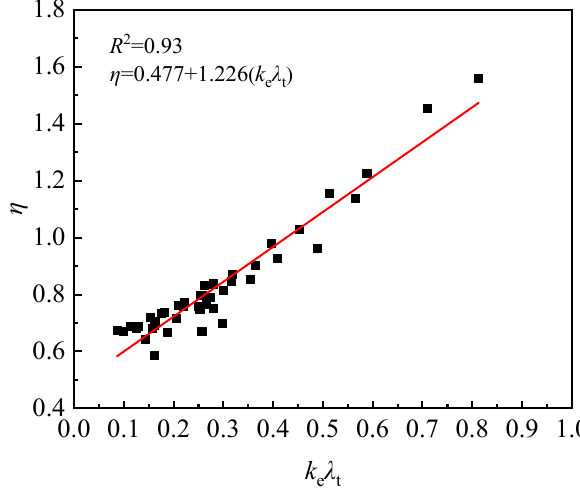
Figure 11. The relationship between the η and k e λ t .